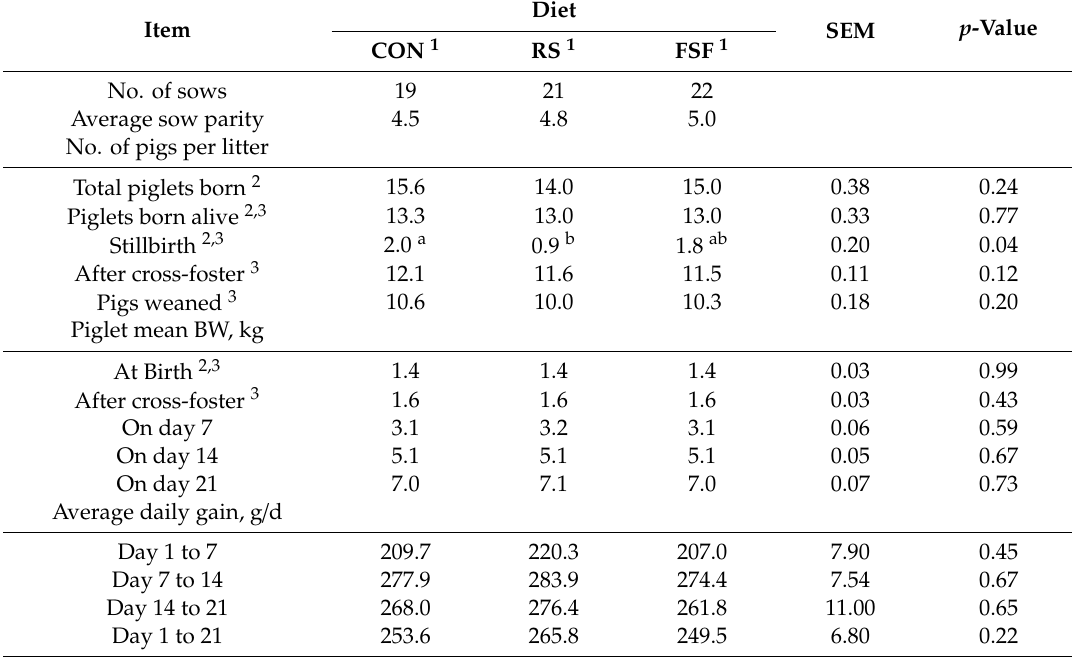
Table 4. E ff ect of inclusion of resistant starch (RS) or fermented soybean fiber (FSF) in gestation diet on litter performance.